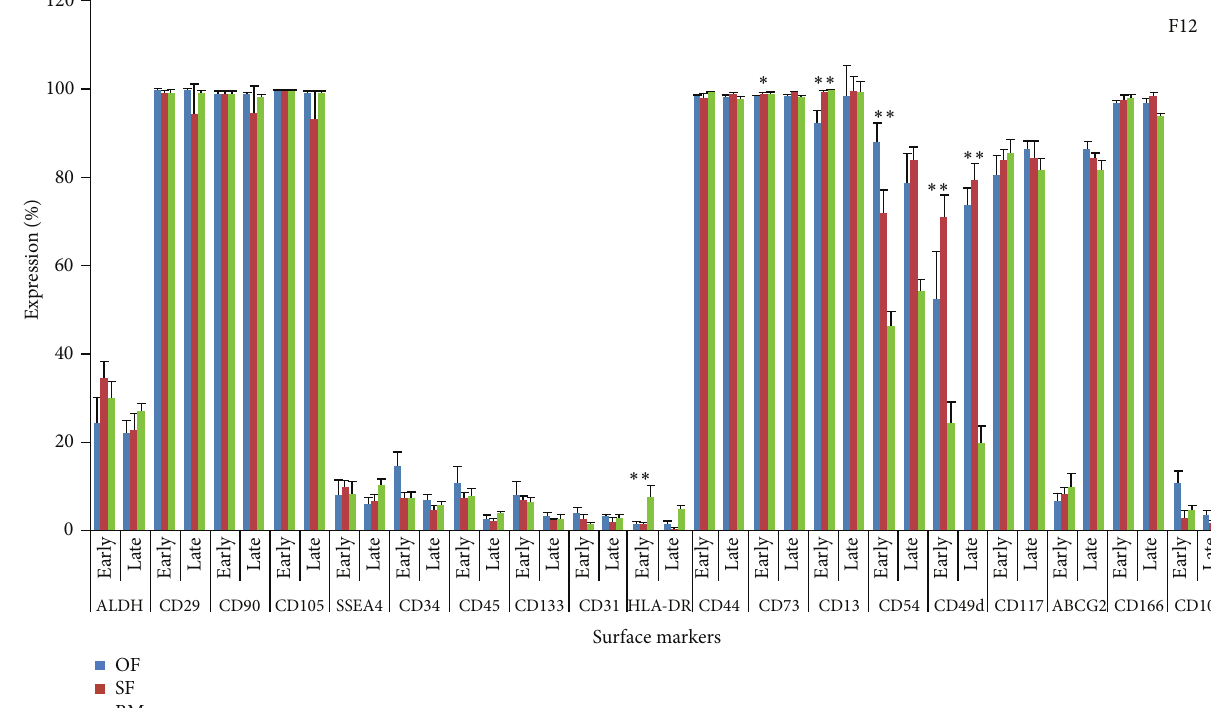
Figure 6: Marker expression profiling of MSCs cultured in DMEM-F12. Comparative Surface antigenic profiling of MSCs derived from omentum fat, subcutaneous fat, and bone marrow at early (P3) and late (P20) passages cultured in DMEM-F12.